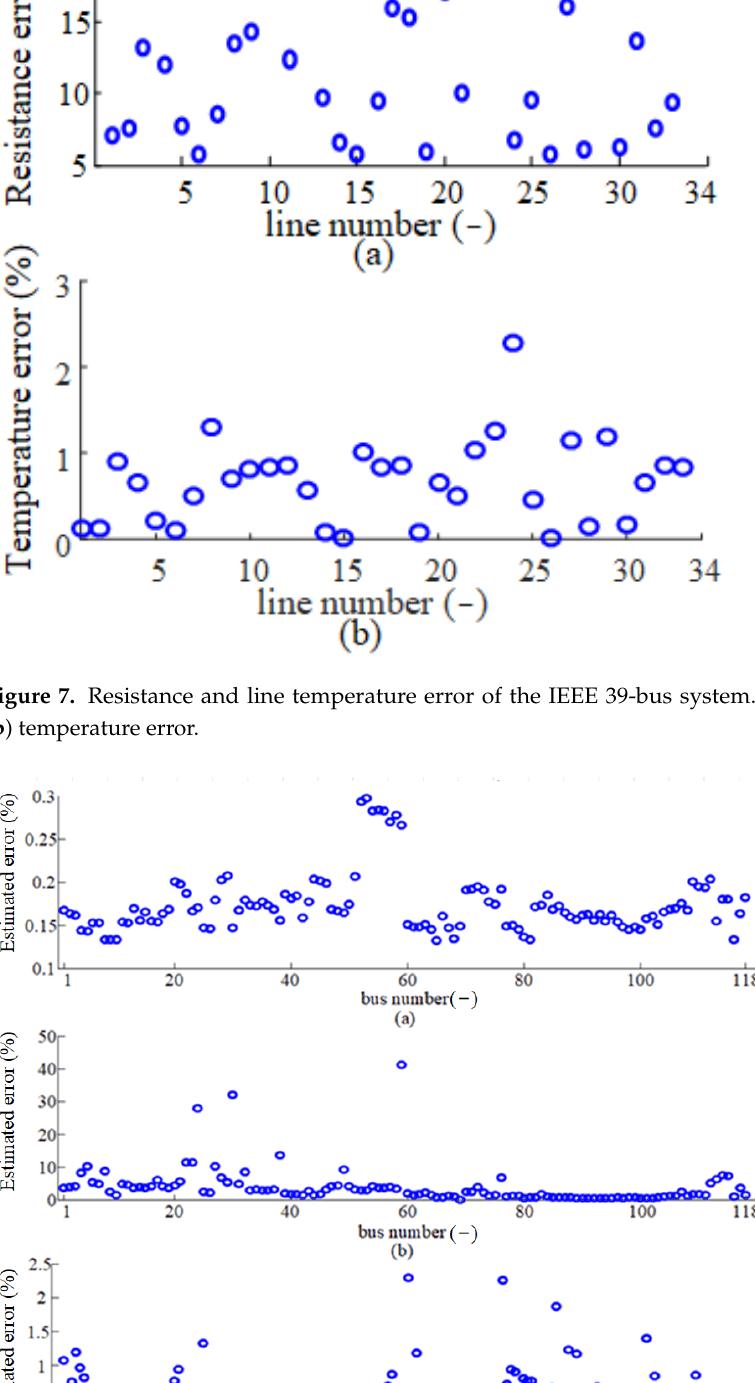
Figure 8. Resistance and line temperature error of the IEEE 118-bus system. ( a ) Voltage amplitude error, ( b ) phase angle error, ( c ) line temperature error.